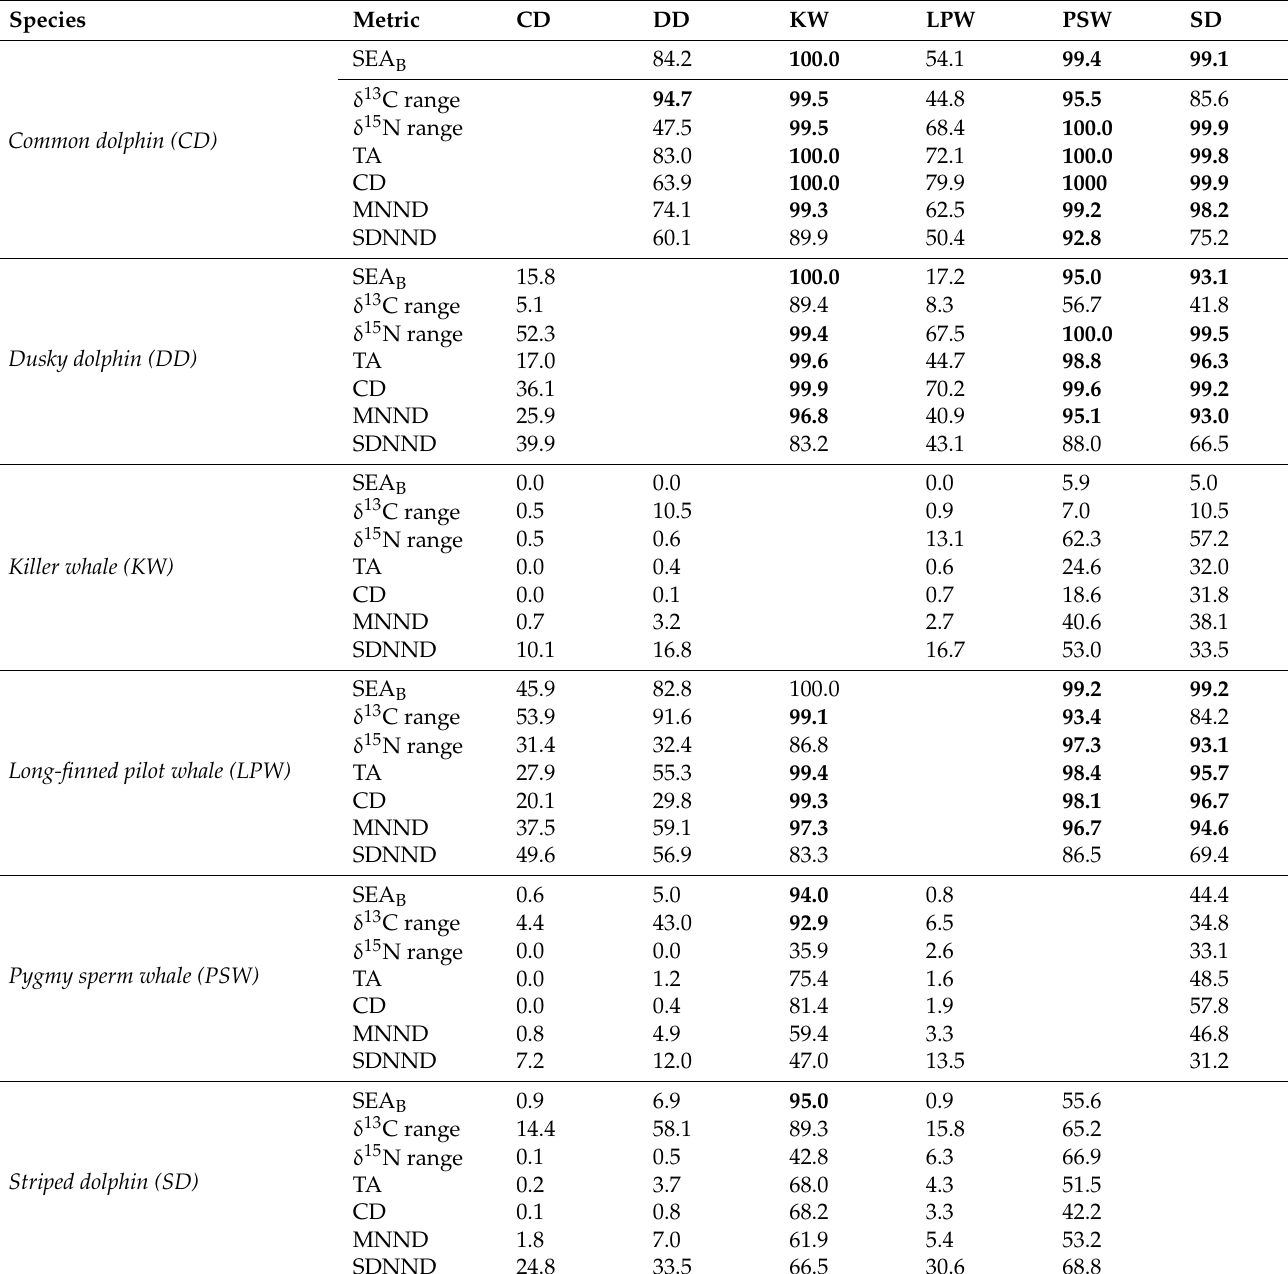
Table 5. The probability of each respective bootstrapped metric being larger in one species over another across all draws for mesopelagic species with n ≥ 10. Species abbreviations: CD = common dolphin, DD = dusky dolphin, KW = killer whale, LPW = long-finned pilot whale, PSW = pygmy sperm whale, SD = striped dolphin. Probabilities ≥ 90% are highlighted in